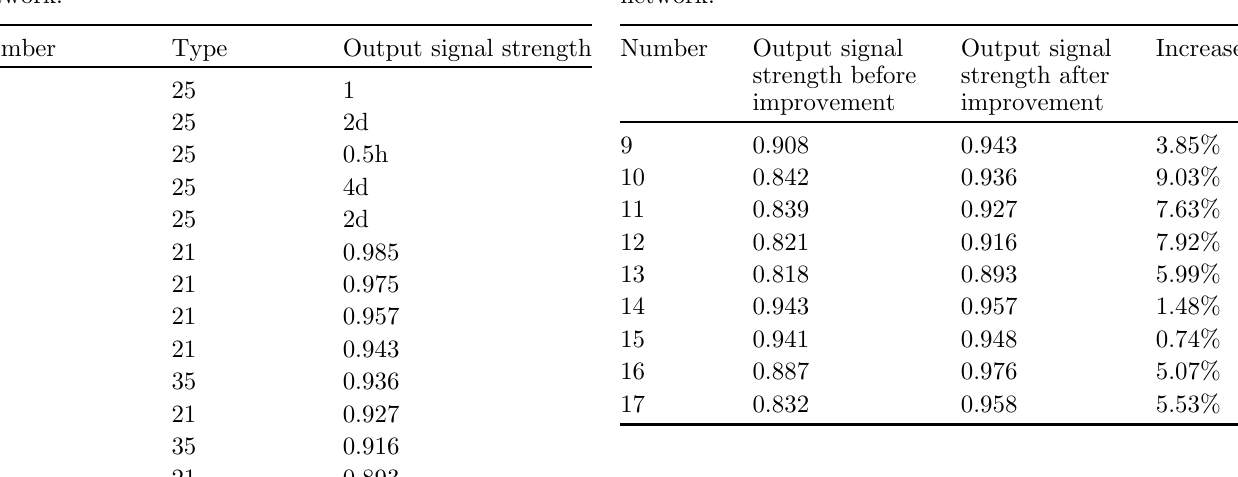
Table 3. The signal strength of the improved logistics network.